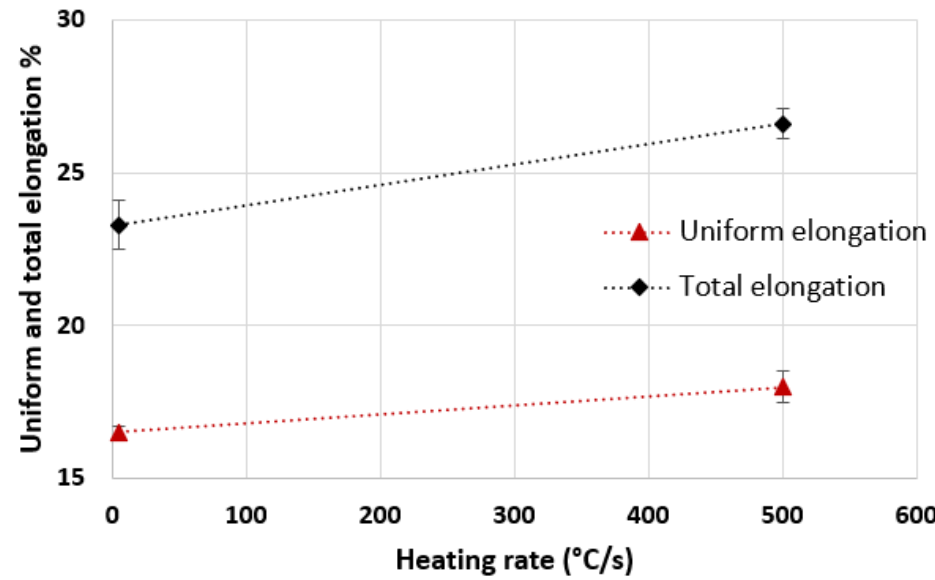
Figure 10. Uniform and total elongation variation with increasing heating rate between CA (5 °C/s) and UFH (500 °C/s) on dual-phase steel (data from [41]).